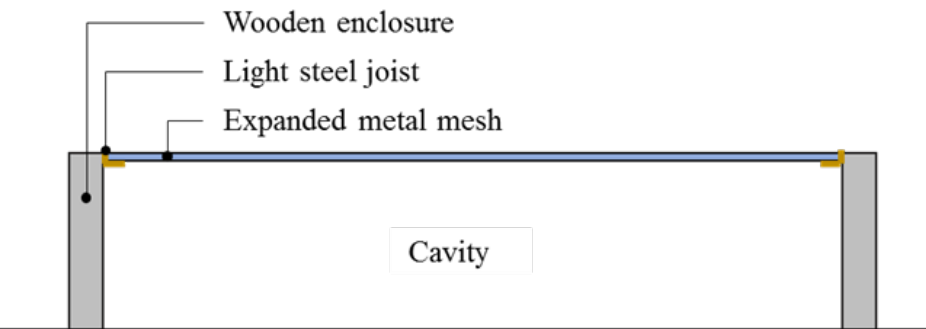
Figure 3. Diagram of the single-panel specimen in the laboratory.